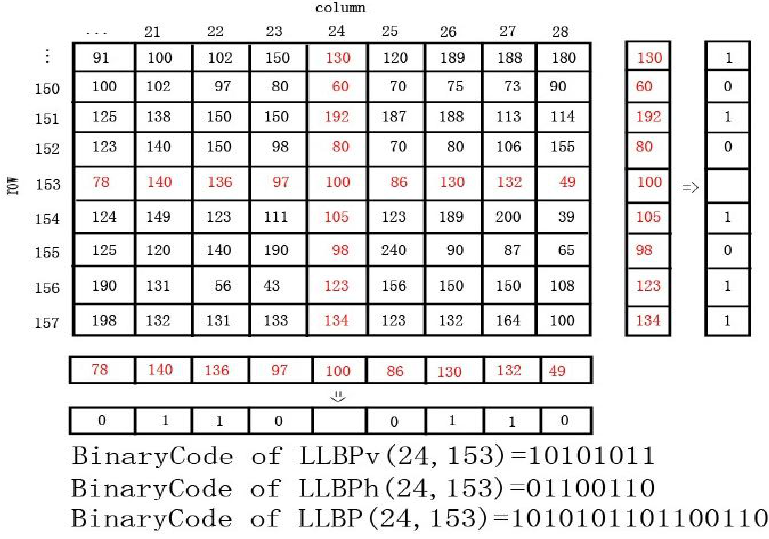
Figure 2. Example of an LLBP